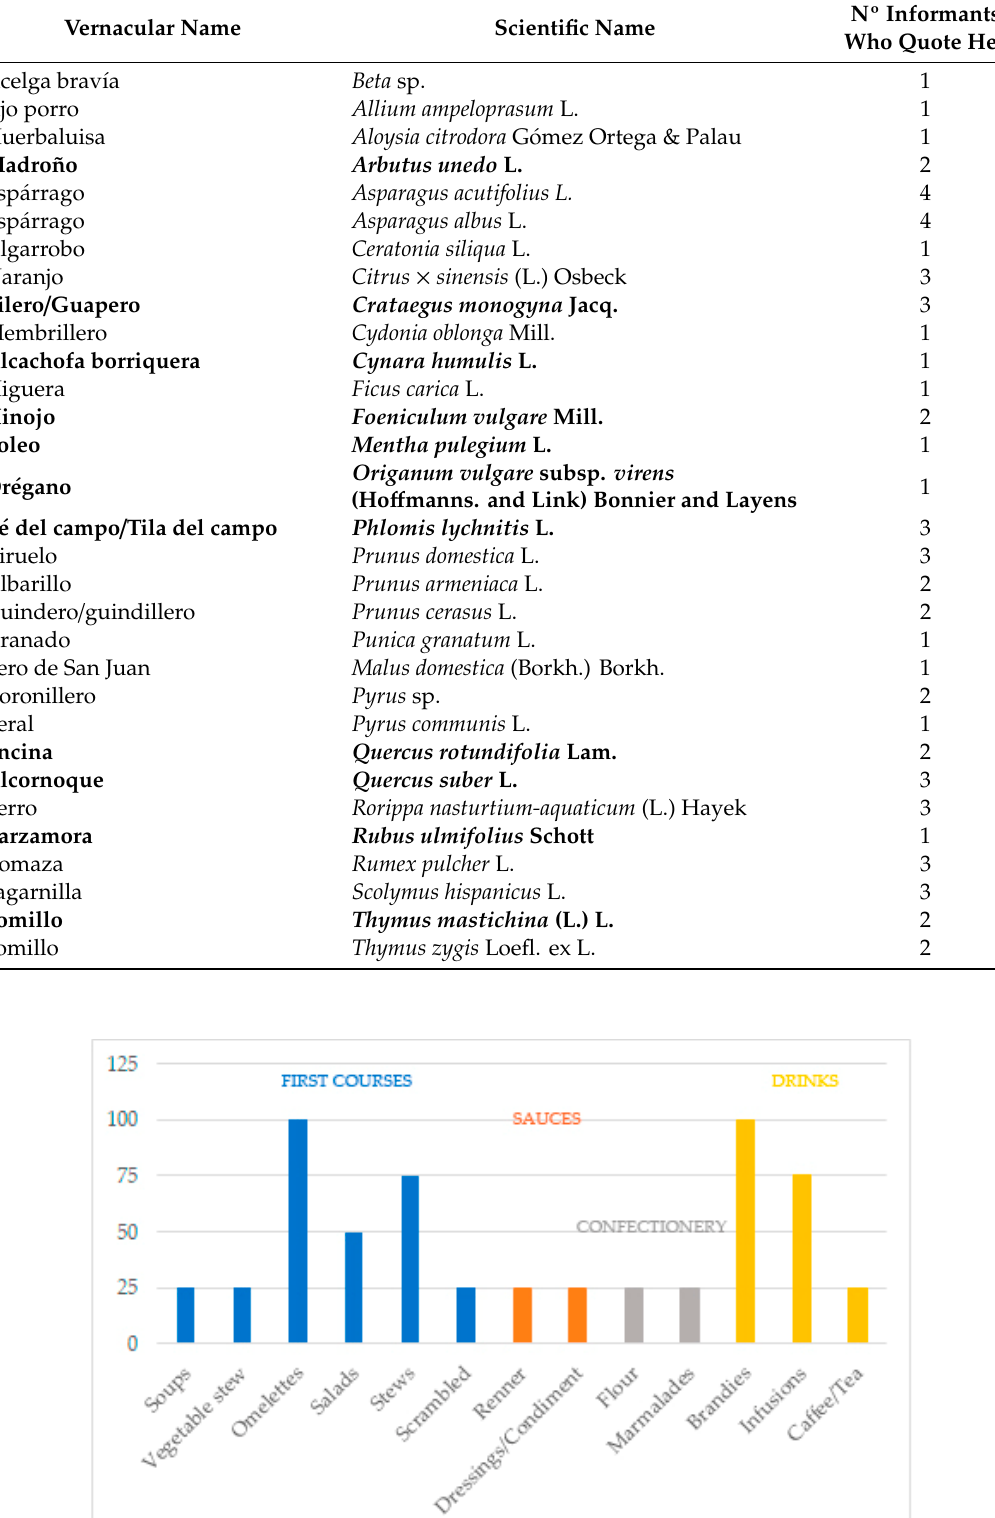
Table 6. Species mentioned and the number of interviewees quoting them. Bold indicates one of the 79 species proposed in this study.